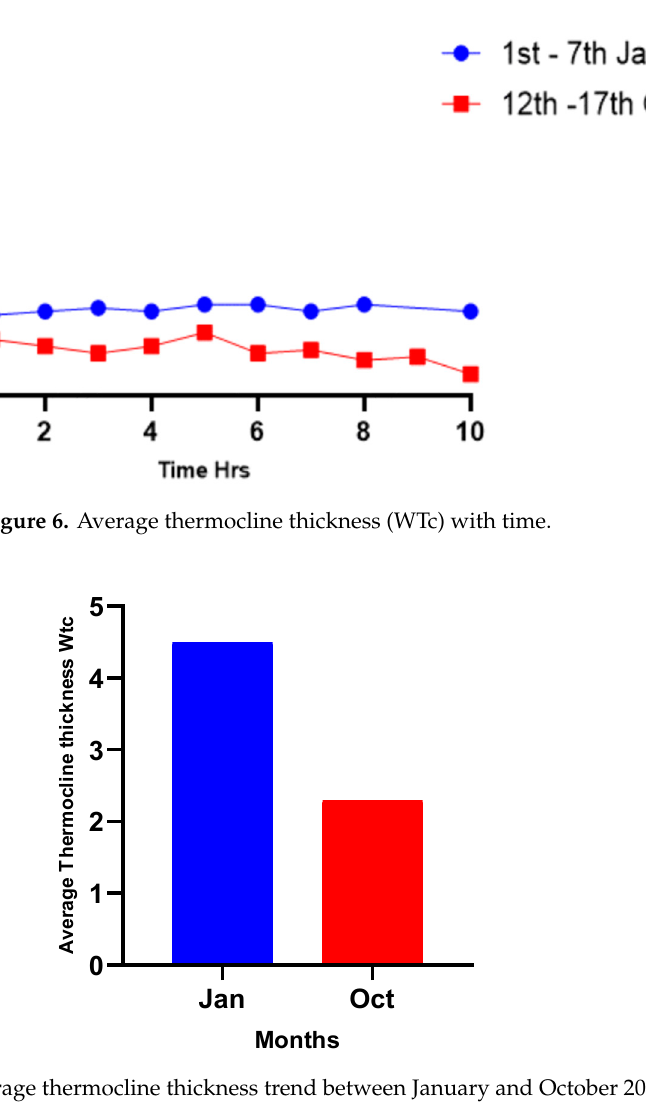
Figure 8. Average cumulative charge over time.